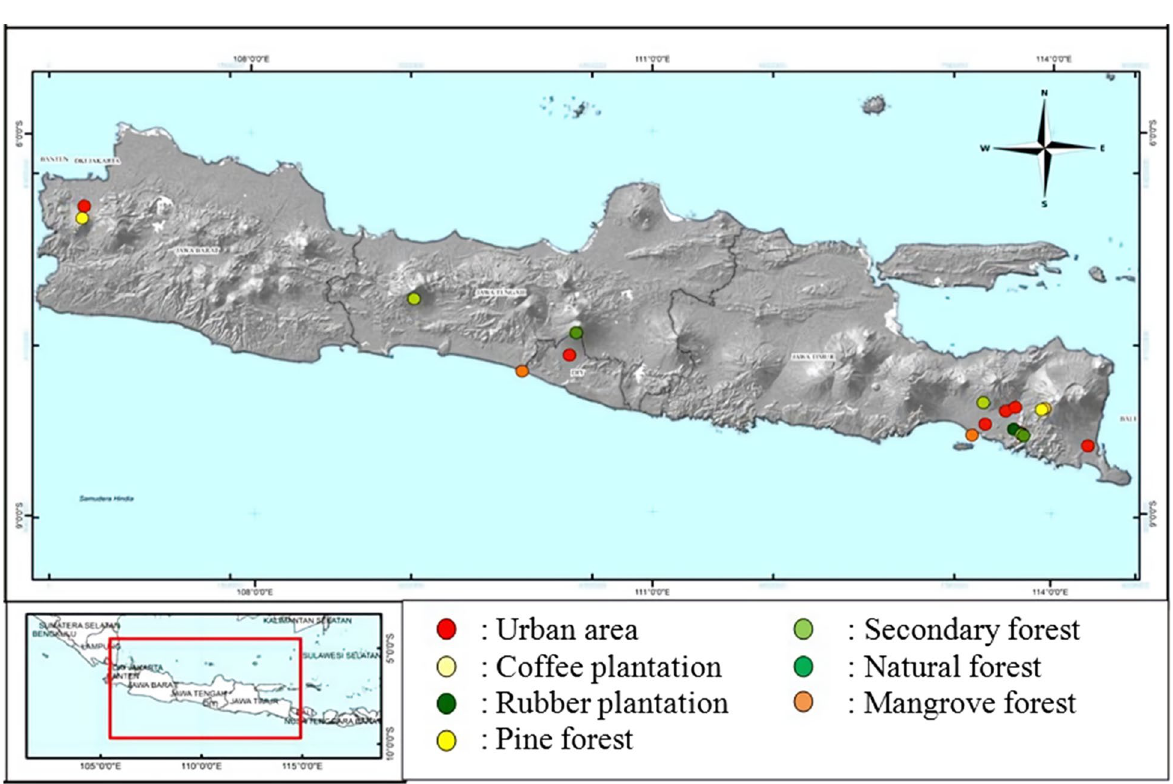
Fig. 1 Location of sample